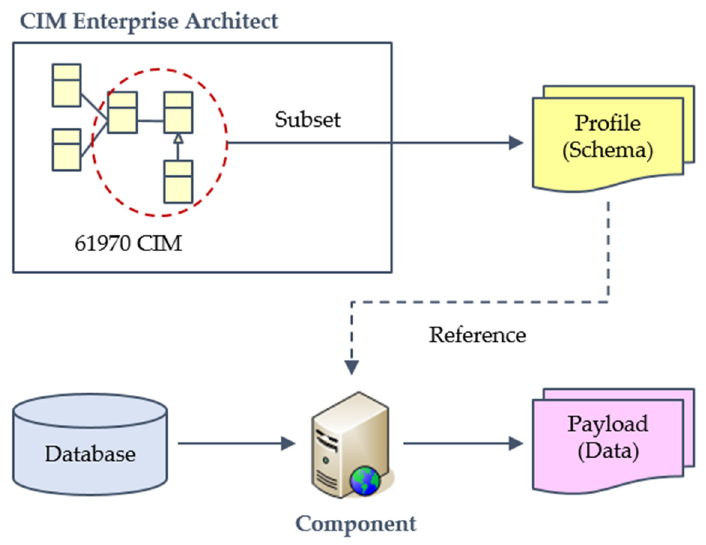
Figure 5. Data creation procedure based on the IEC 61970 CIM.